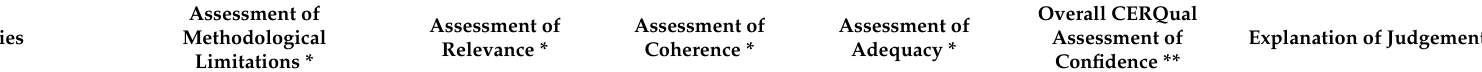
Table 5. Quality